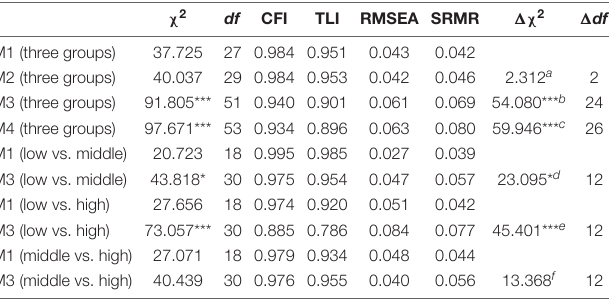
TABLE 5 | Multiple group analysis in study